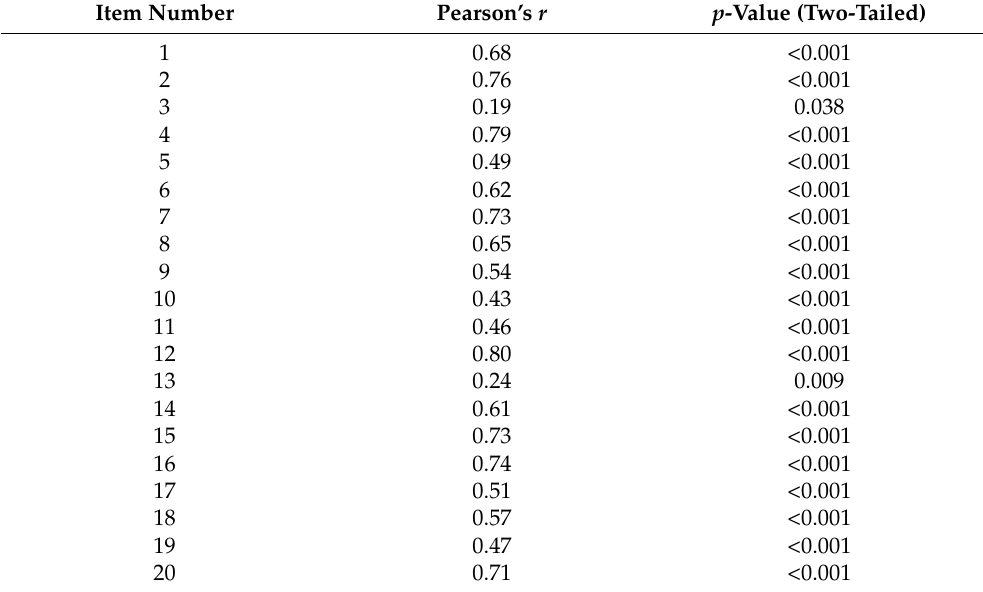
Table 3. Item-total correlations for the PI20 DK (N =